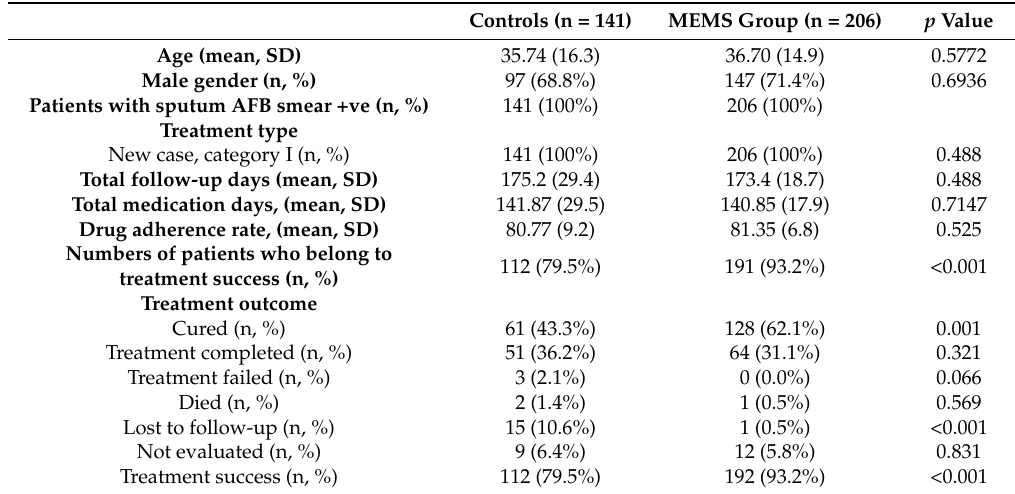
Table 1. Comparison of general characteristics and treatment results between the control group and the Medication Event Monitoring System (MEMS)